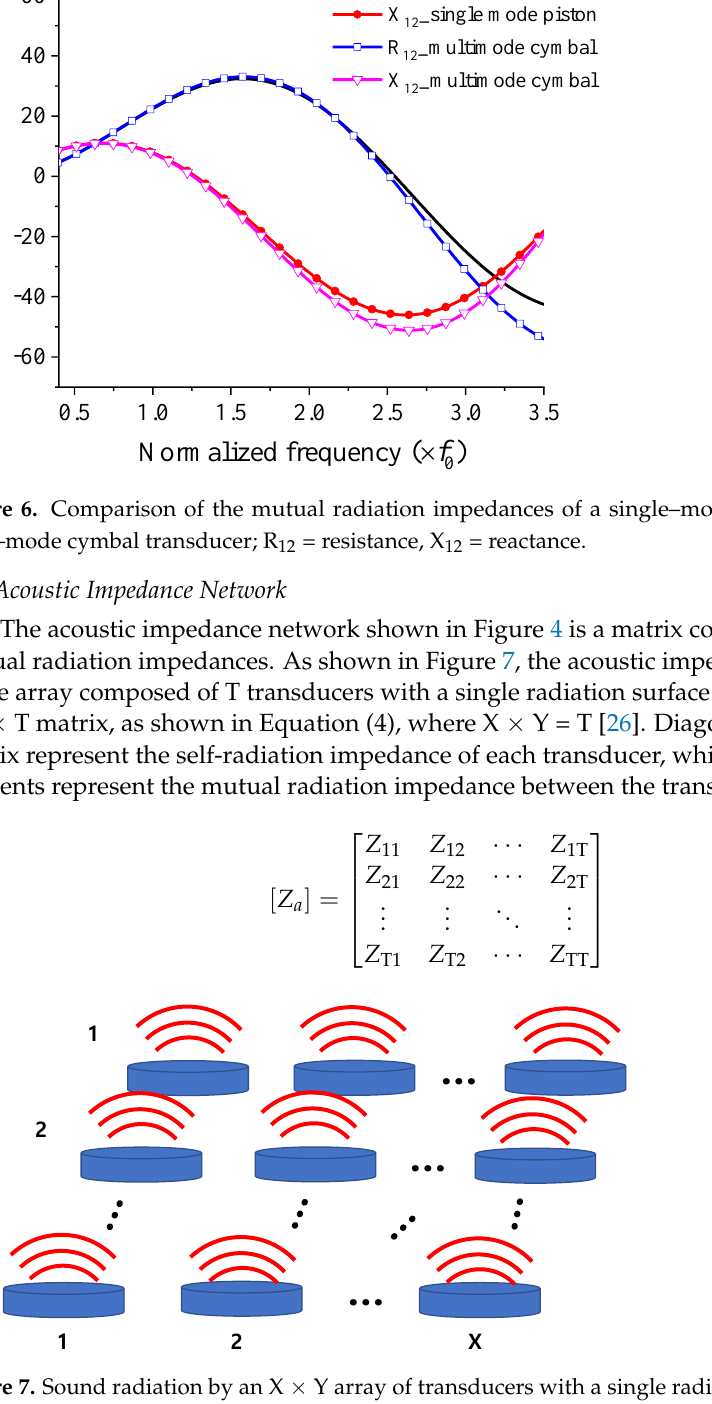
Figure 7. Sound radiation by an X × Y array of transducers with a single radiation surface.